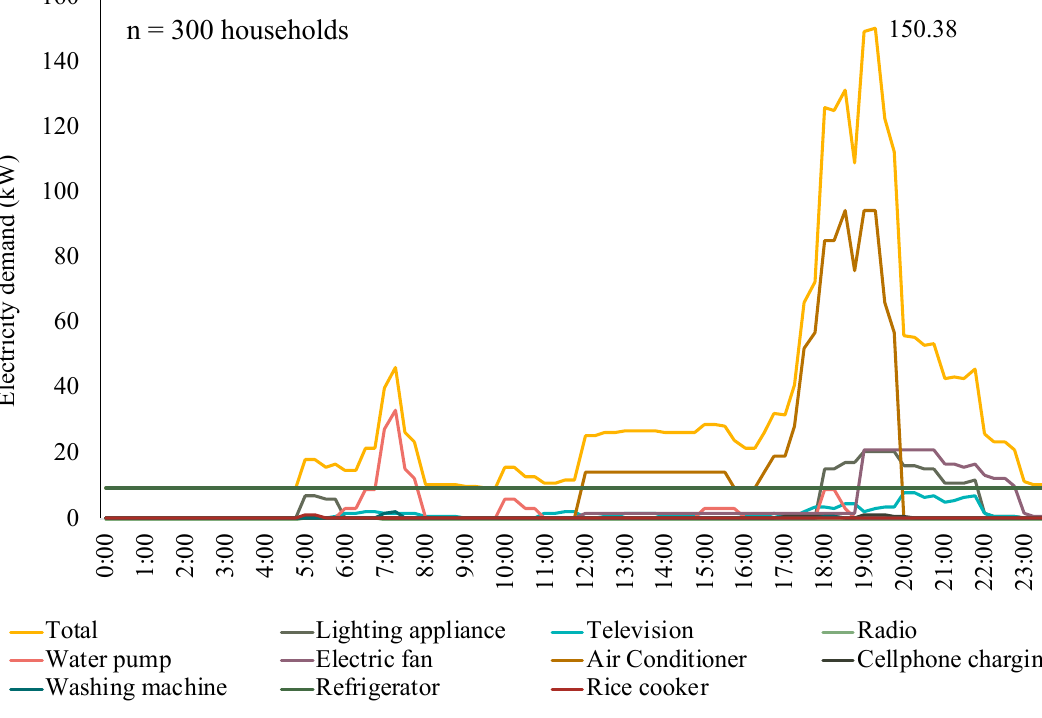
Figure 6. Current electricity demand daily load pattern of the Myanmar case study (during the warm season).